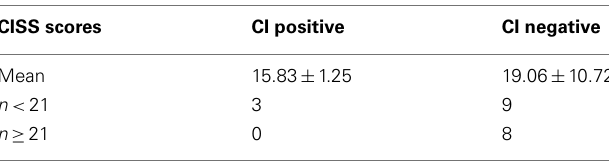
Table 3 | SZ CISS scores and CISS classification frequency by CI diagnosis a